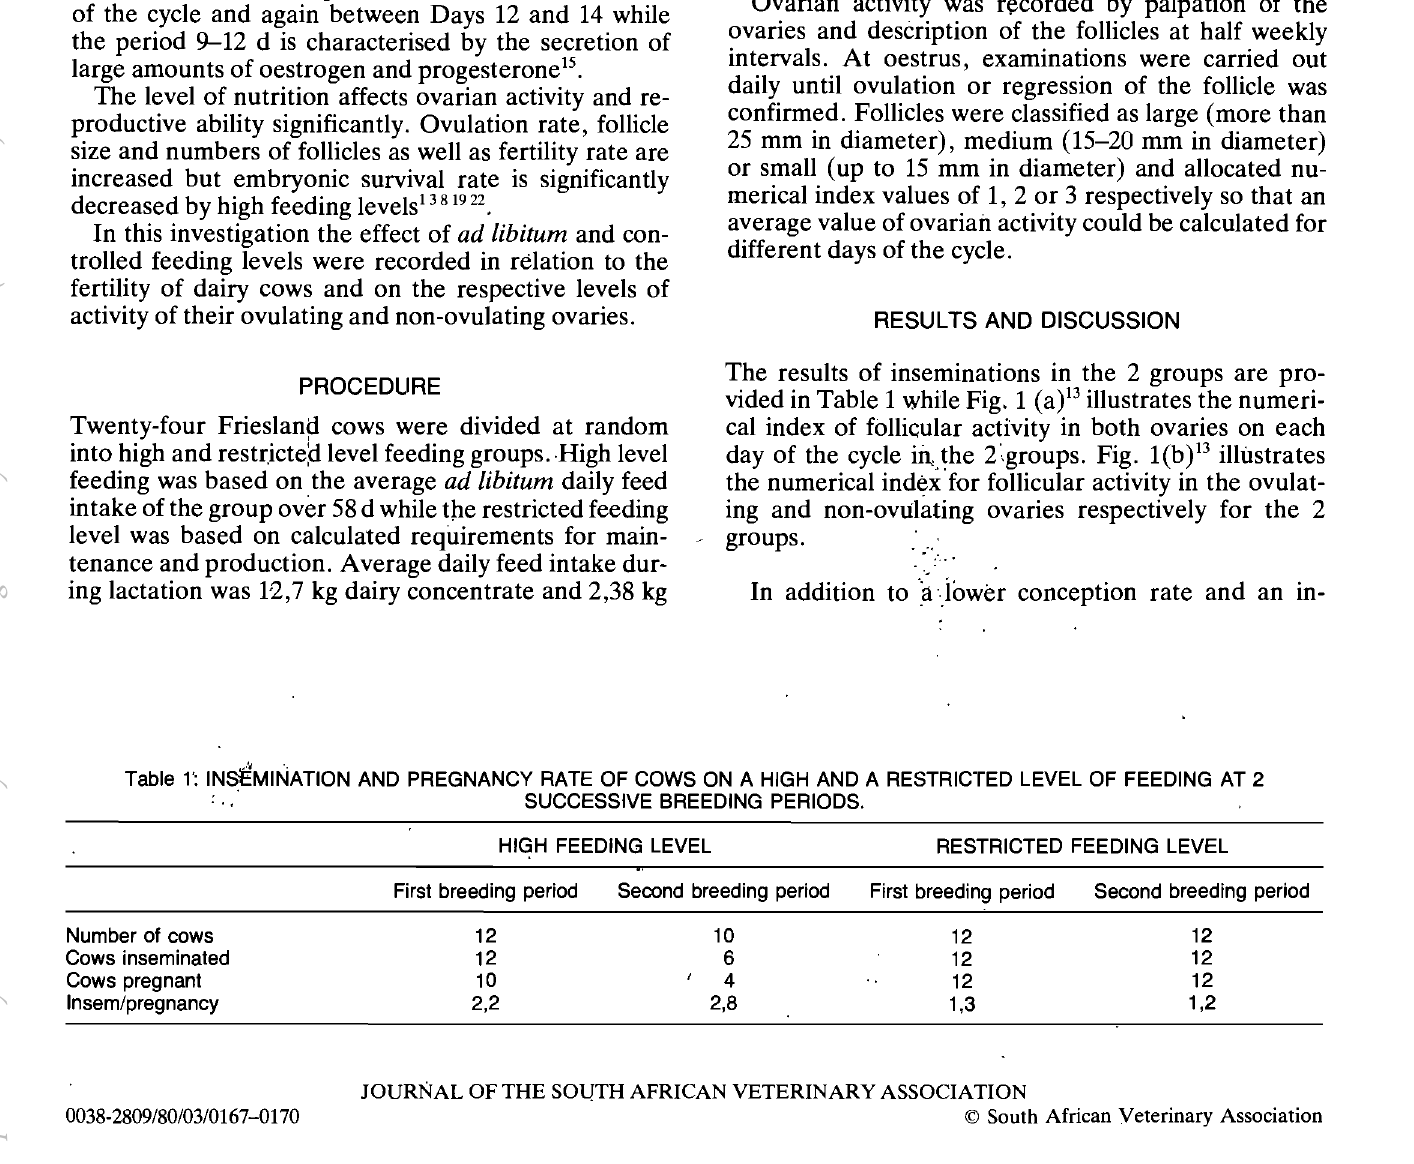
Table 1': INseMINATION AND PREGNANCY RATE OF COWS ON A HIGH AND A RESTRICTED LEVEL OF FEEDING AT 2 . , .' SUCCESSIVE BREEDING